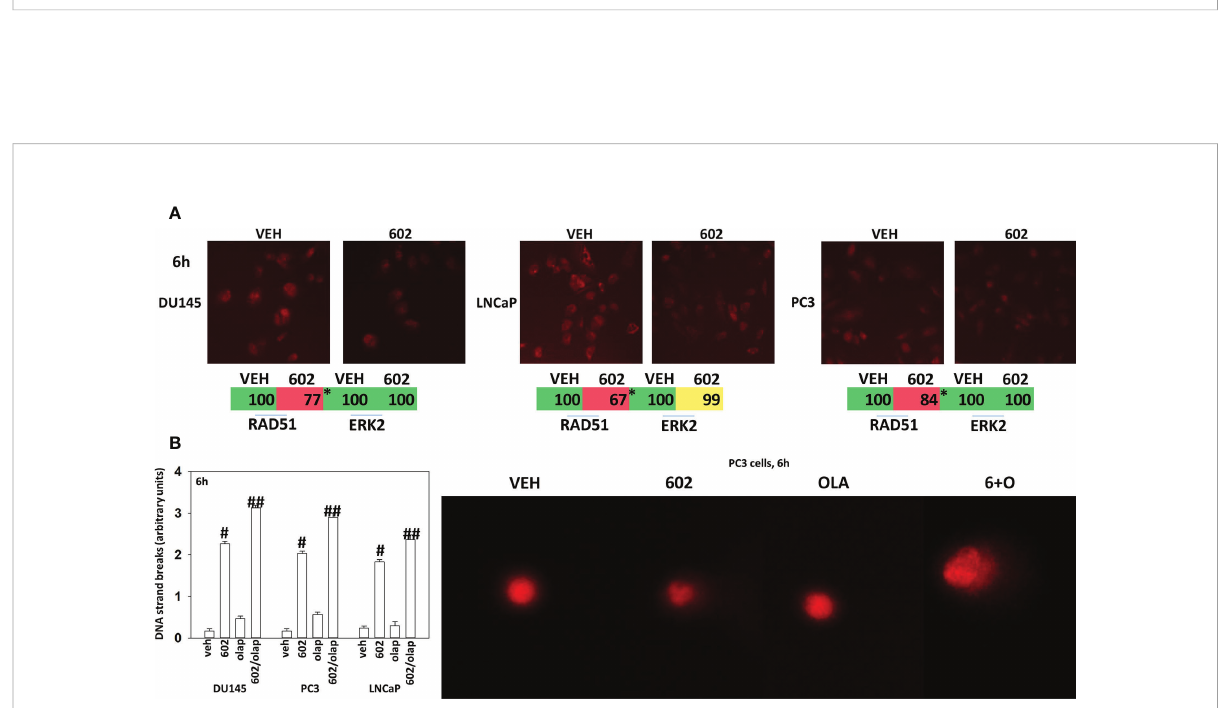
FIGURE 14 GZ17-6.02 reduces RAD51 expression and increases DNA damage. (A) Cells were treated with vehicle control or with GZ17-6.02 (2 m M). Cells were fi xed 6h after drug exposure. Cells were fi xed in situ, permeabilized, stained with the indicated validated primary antibodies and imaged with secondary antibodies carrying red- and green- fl uorescent tags. The staining intensity of at least 100 cells per well/condition is determine in three separate studies. The data are the normalized amount of fl uorescence set at 100% comparing intensity values for vehicle control (n = 3 +/-SD). #p < 0.05 greater than vehicle control; *p < 0.05 less than vehicle control. (B) Drug-treated cells, in suspension, were mixed with low melting point agarose and spread onto a microscope glass slide. After lysis of cells with detergent at a high salt concentration, DNA unwinding and electrophoresis was carried out at neutral pH (7-8). Tail moments were scored using a Method which classi fi es comets from grades 0 – 4 (11 – 13). One hundred comets were scored, and each comet assigned a value of 0 to 4 according to its class, the mean total score for the sample gel will be between 0 and 4 “ arbitrary units. ” (n = 3 +/-SD) # p < 0.05 greater than vehicle control; ##p < 0.05 greater than GZ17-6.02 alone